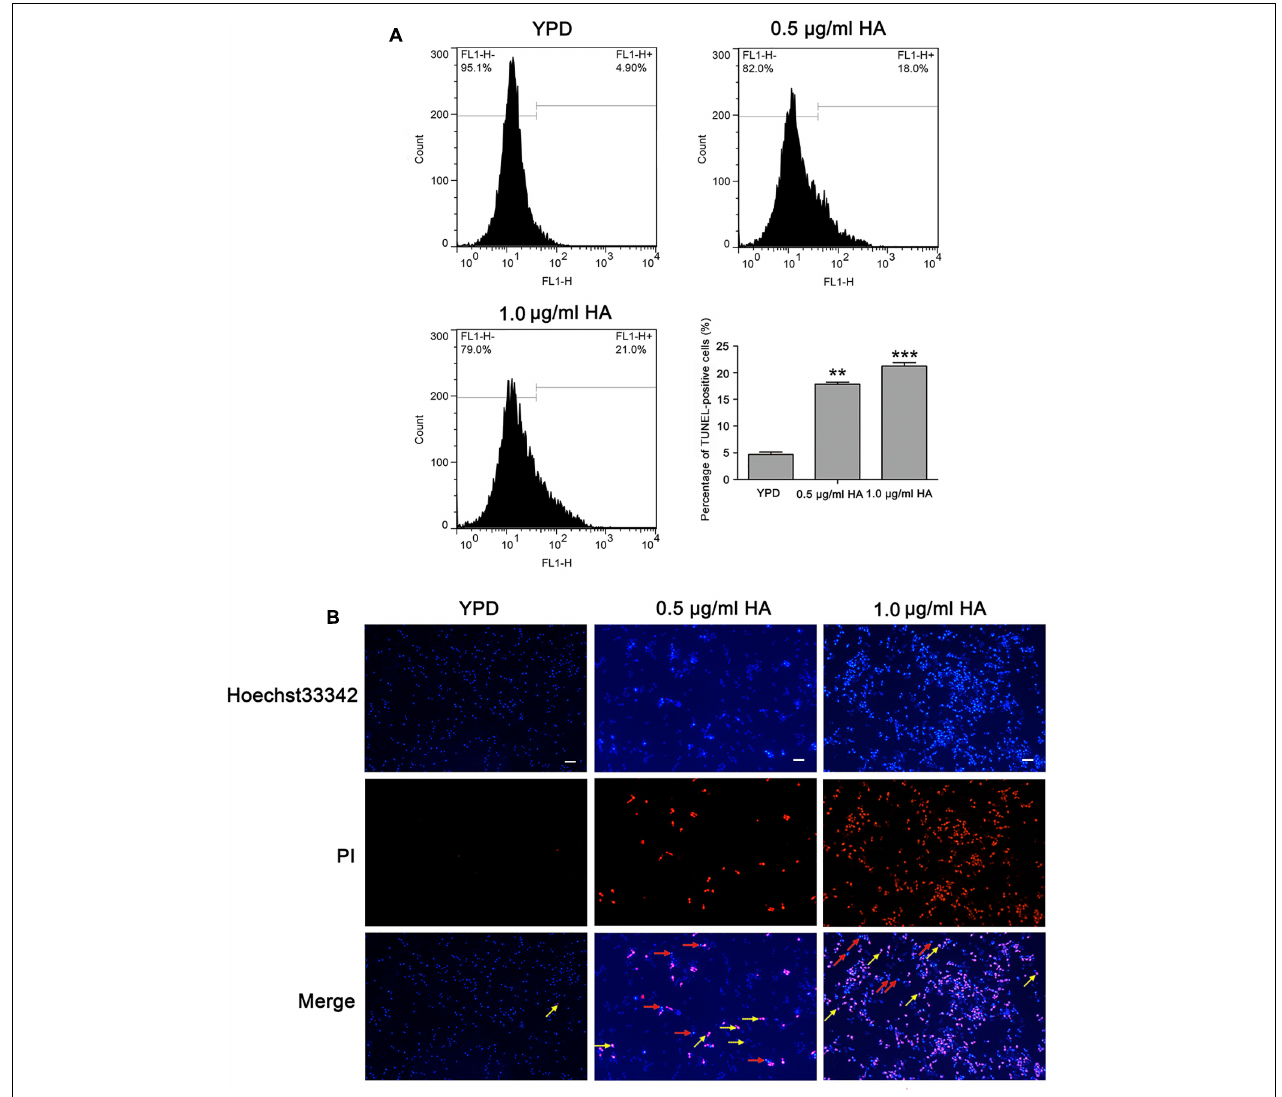
FIGURE 5 | DNA fragmentation and nuclear condensation were examined in C. albicans cells after treatment with HA. (A) DNA fragmentation was analyzed by flow cytometry using TUNEL staining. The histogram showed the percentage of TUNEL-positive cells, and the values were expressed as mean ± SD ( n = 3). ∗∗ P < 0.01 and ∗∗∗ P < 0.001. (B) Nuclear condensation was visualized with a fluorescence microscope using Hoechst33342/PI co-staining. The red arrows pointed to the apoptotic cells, and the yellow arrows indicated the necrotic cells. Scale bars = 10 µ